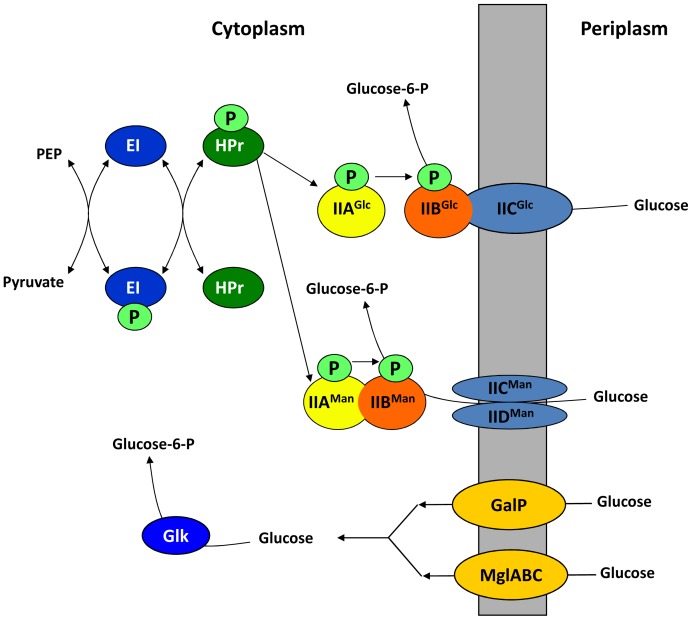
Summary of glucose transport in Salmonella
[49].Glucose can be taken up by the EIIGlc and/or the EIIMan transporters and simultaneously phosphorylated to generate glucose-6-phosphate. The EIIGlc PTS transporter is encoded by two genes; crr encodes the IIAGlc protein whilst ptsG encodes the membrane-bound IIBCGlc protein. The EIIMan PTS transporter is encoded by three genes, manX, manY and manZ that encode the IIABMan, and the IICMan and IIDMan components of the transporter system, respectively. In order to transport and phosphorylate glucose, the EIIGlc and EIIMan transporters require phosphate donated from phosphoenol-pyruvate (PEP) via the EI and HPr phospho-relay proteins that are encoded by ptsI and ptsH, respectively. In addition, unphosphorylated glucose can be imported by the GalP and/or MglABC transporters then subsequently phosphorylated by glucose kinase (Glk) to produce glucose-6-phosphate.